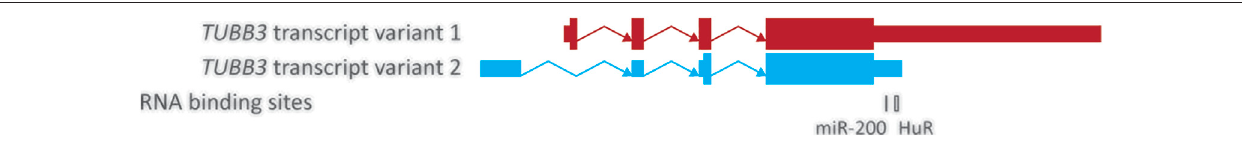
FIGURE 3 | Structure of the common TUBB3 mRNA transcripts. Structure of the two common TUBB3 transcripts showing the validated binding sites of the HuR proteinandthemiR-200family.Transcriptsarerepresentedbyacombinationofthinandthickboxesforexons,andarrowsforintrons;thinboxesrepresentuntranslated regions (5 ′ and 3 ’ UTRs), while thick boxes representtranslated regions. TUBB3 transcriptvariants 1and 2 are show inred and blue respectively and have been aligned to show common regions. RNA binding sites represented by boxes under their approximate location, with thickness corresponding to size. HuR binding site validatedby(Prisleietal.,2013);miR-200cbindingcon fi rmedby(Cochraneetal.,2009);miR-200bbindingcon fi